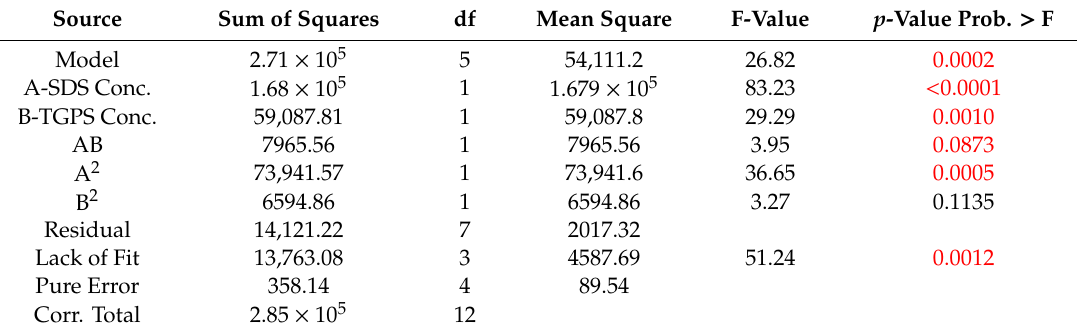
Table 4. ANOVA data for response surface quadratic model for